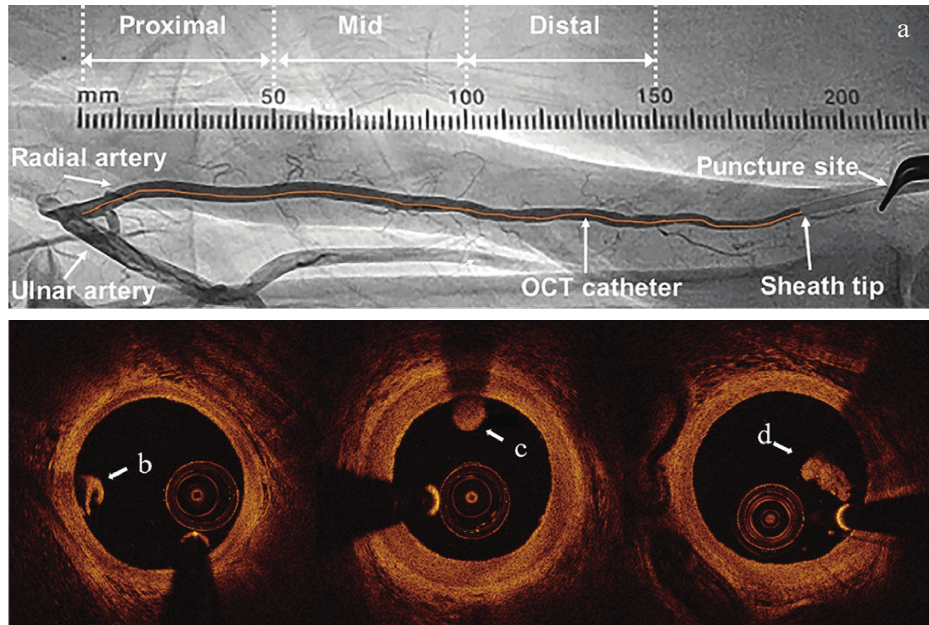
Figure 2: Radial artery OCT imaging method and thrombus under OCT: a, radial artery OCT imaging at proximal, middle, and distal portions, b, white thrombus in the radial artery under OCT, c, red thrombus, and d, mixed